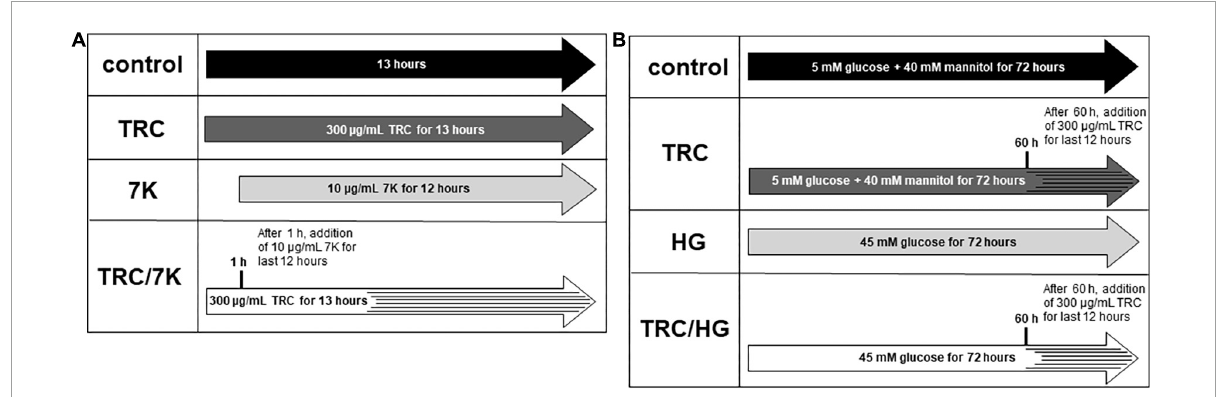
FIGURE1 Experimental design. (A) Experiments performed with 7-ketocholesterol (7K). (B) Experiments performed with high glucose (HG). 7K, 7-ketocholesterol; TRC, TRC105; HG, high glucose. To analyze Smad signaling in HAoECs, cells were serum-starved in EBM-2 medium for 22 h and then pretreated with TRC105 for 90 min. HAoECs were stimulated with either 7-ketocholesterol or glucose for 30 min after TRC105